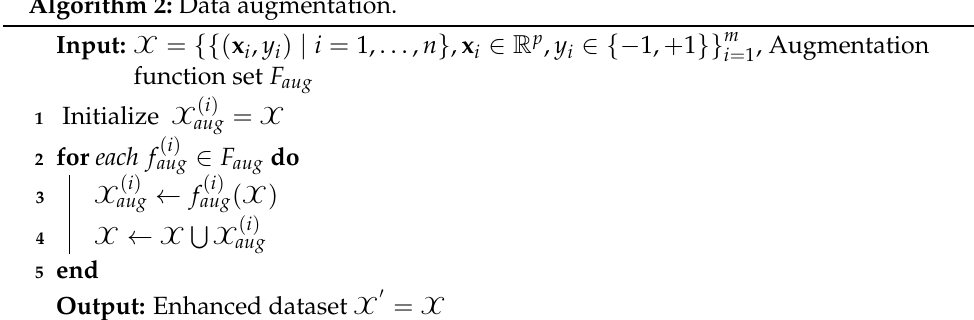
Algorithm 2: Data